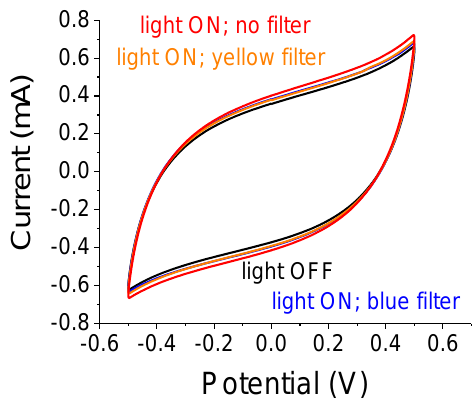
Figure 3. Cycle-voltammetry (C-V) for 0.2 µm particles embedded in A-C/PMMA using a 2-electrode setup. The S-C was illuminated by a 75 W white-light source. The cases with no filter (red), blue, and yellow filters are shown. The scan rate was 0.1 V/s.